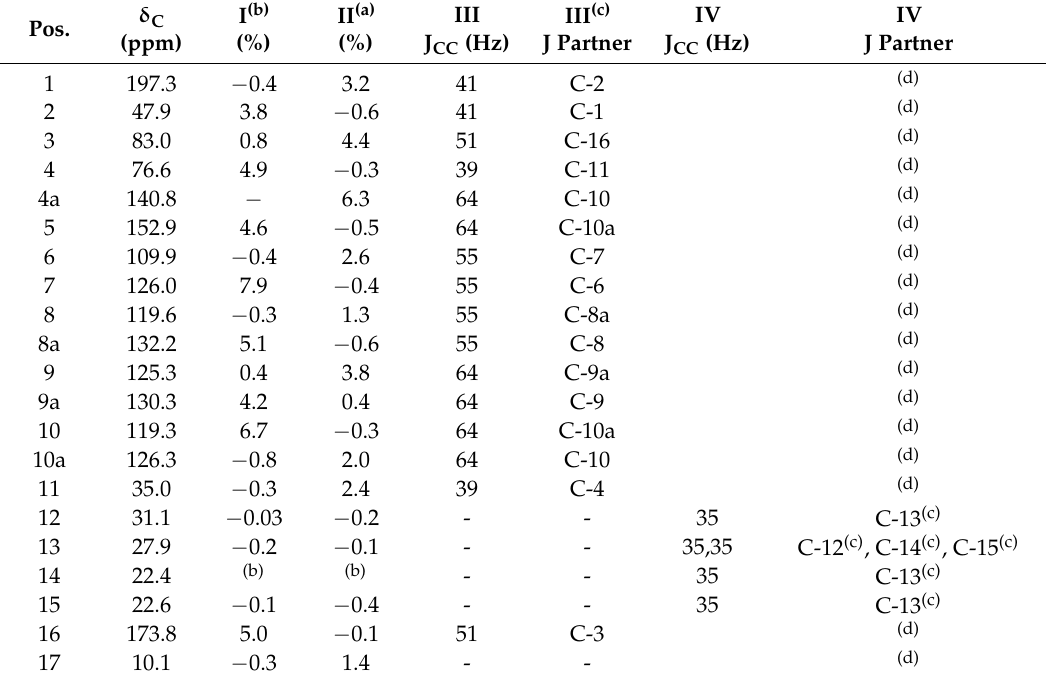
Table 1. 13 C-NMR signals of rishirilide B together with specific incorporations and coupling constants after feeding with [1- 13 C]acetate (I), [2- 13 C]acetate (II), [1,2- 13 C 2 ]acetate (III) and [ 13 c 5 , 15 n]- L -valine